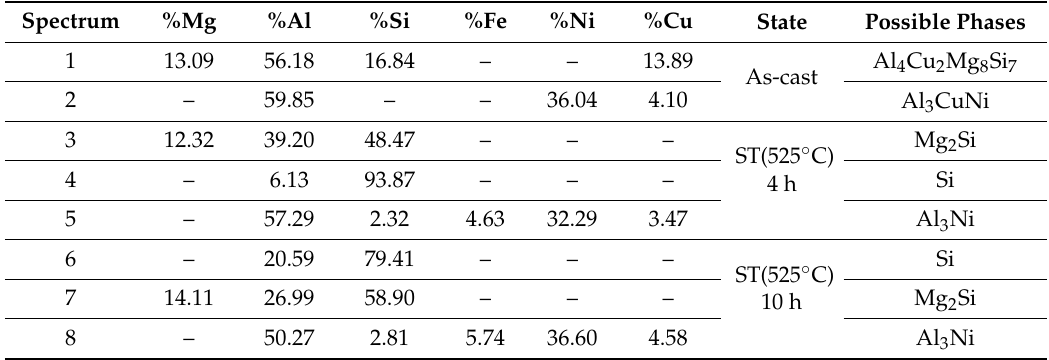
Table 3. Semi-quantitative analysis of the phases indicated in Figure 5, carried out by energy dispersive X-ray (EDX) microanalysis (% in weight).